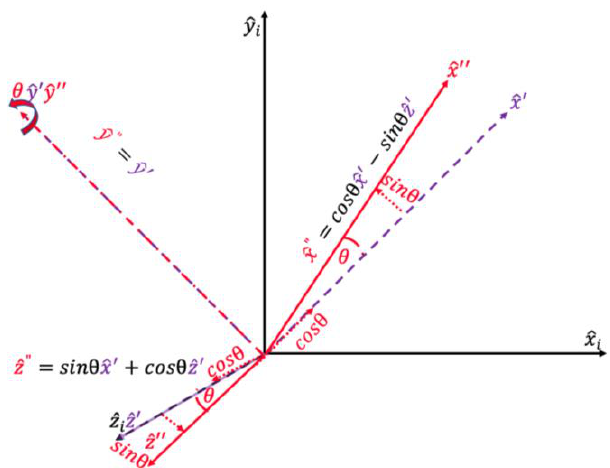
Figure 3. 2-rotation about the y′̂ and y”̂ axes [23].